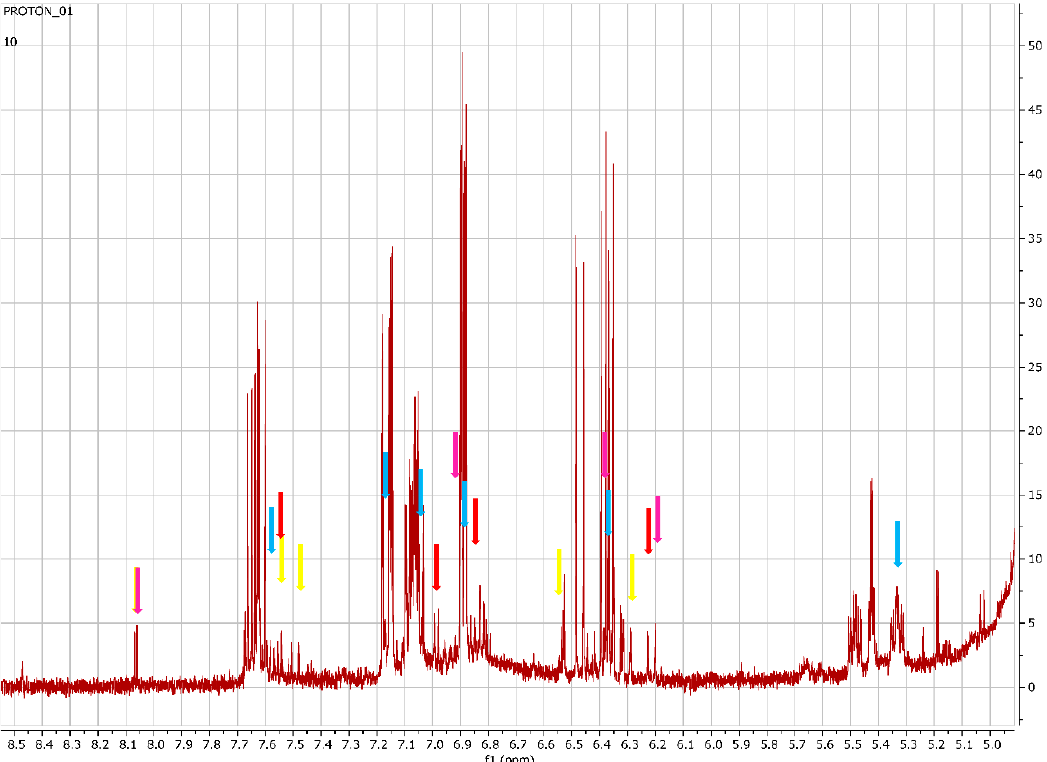
Figure 12. Peaks of the annotated compounds indicated for each of the compounds. Yellow = galangin (8.06, 7.58, 7.49, 6.54, 6.28 ppm); purple = kaempferol (8.06, 6.94, 6.44, 6.20 ppm); blue = chlorogenic acid (7.56, 7.06, 7.03, 6.83, 6.22, 5.33 ppm); red = quercetin (7.66, 7.54, 6.88, 6.20 ppm).